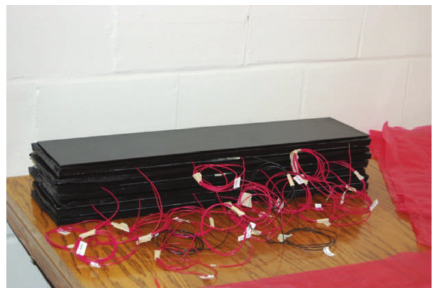
Figure 18: Fully-assembled bearing prototype [47].